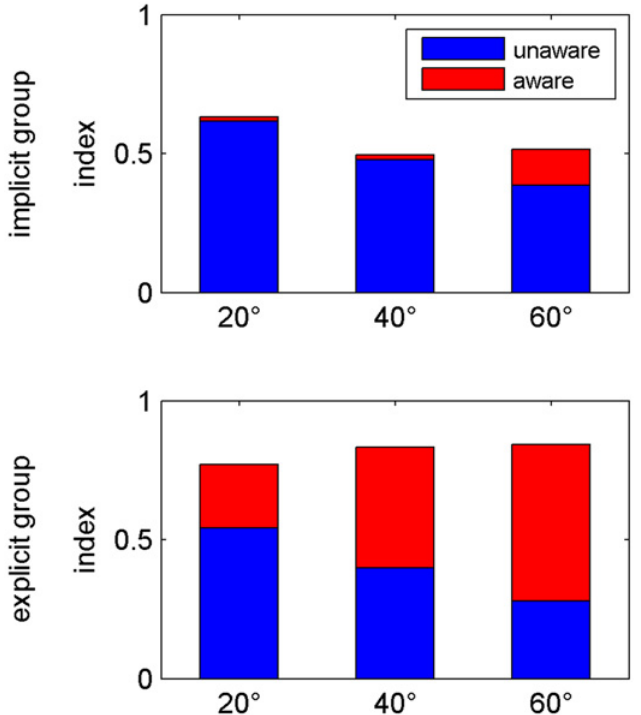
index statistical analysis revealed significant effects of Group (p < 0.01) and Rotation Size (p < 0.05), but no significant interaction (p > 0.05). For the unawareness index the analysis yielded a significant effect of Rotation Size (p < 0.001), but no significant effects of Group or Group × Rotation Size (both p >